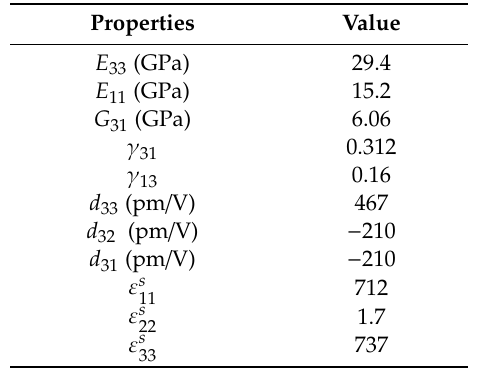
Figure 7. The homogenized PFP bending test’s configuration. Two PFPs (85 × 57 mm 2 in size) were attached to the front and the back of an aluminum beam. The PFP1 was driven by a voltage to be extended, while the PFP2 remained as a closed-circuit. In the experiment, 30 mm of the 330-mm-long aluminum beam was fixed by a clamp [31]. In the simulation, the aluminum beam was modelled with a length of 300 mm and with fixed boundary conditions at the left end. Table 1. The e ff ective material properties of the homogenized M8557P1 PFP [31]: Young’s modulus ( E ), shear modulus ( G ), Poisson’s ratio ( γ ), piezoelectric coupling coe ffi cients ( d ij ), and relative permittivity at constant strain ( ε s ij